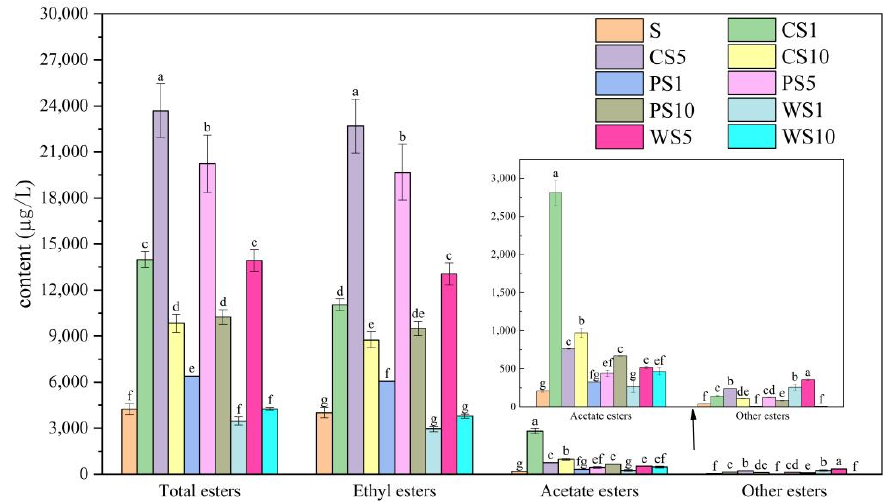
Figure 5. Contents of ester compounds of different ester-producing yeasts, with S. cerevisiae NCUF309.2 at different ratios during simulated fermentation of blueberry wine. (Different letters represent significantly different ( p <